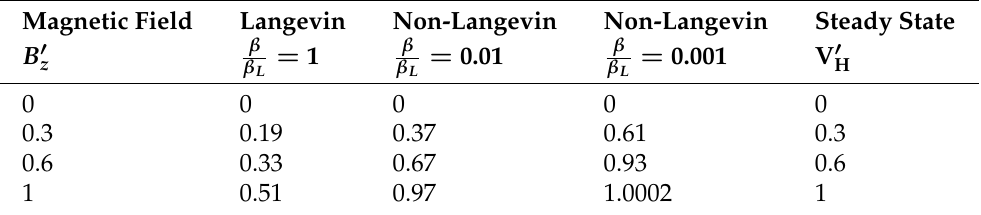
Table 1. Hall voltages in Langevin, non-Langevin, and steady-state